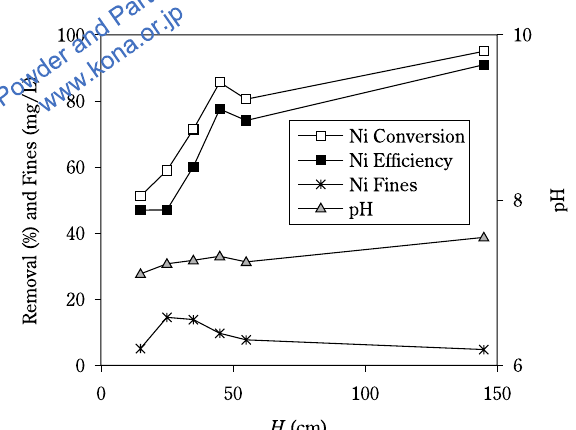
Fig. 7 Conversion, efficiency, fines concentration and pH for nickel in a mixed nickel-cobalt sulphide precipitation.